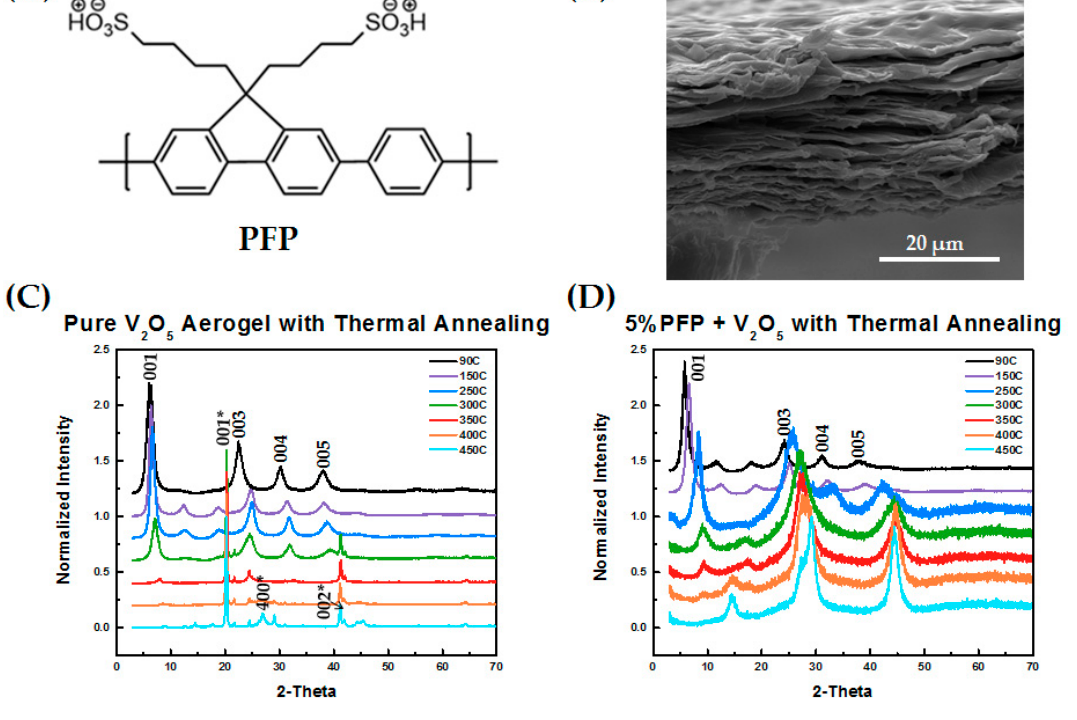
Figure 1. ( A ) Chemical structure of poly(9,9-bis(4 (cid:48) -sulfonatobutyl)fluorene-alt-co-1,4-phenylene) (PFP); ( B ) SEM image of V 2 O 5 layered structure; ( C , D ) X-ray diffraction (XRD) patterns with thermal annealing from 90 ◦ C to 450 ◦ C for ( C ) pure V 2 O 5 and ( D ) V 2 O 5 blends with 5 wt % PFP,